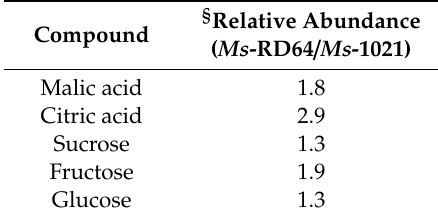
Table 2. Di ff erences in the production of some metabolites in Medicago plants nodulated by 1021 and RD64